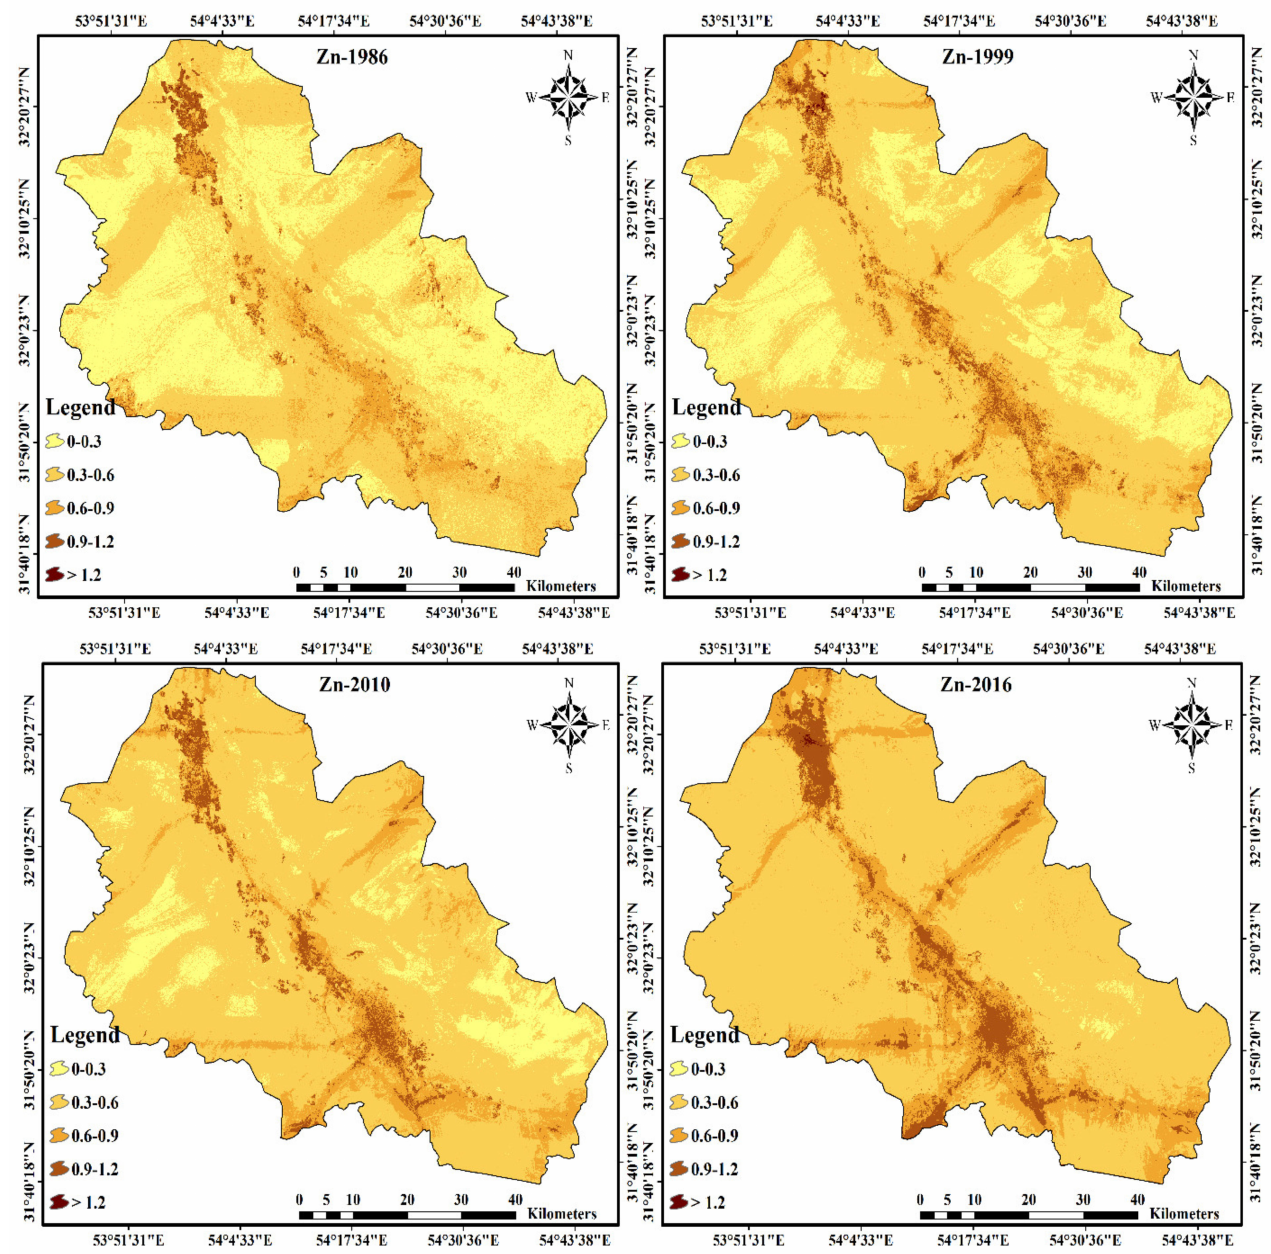
Figure 10. The spatial prediction of Zn (mg/kg − 1 ) for 1986, 1999, 2010, and 2016. With respect to Pb concentrations, the areal extent of the 1–1.5, 1.5–2, and >2.5 mg/kg − 1 classes increased by 8.75% (42,258 ha), 25.18% (121,633 ha), and 2.18% (10,562 ha), respec- tively, while the areal extent of the 0–1 mg/kg − 1 class decreased by 36.56% (176,565 ha) (Figure 11). Furthermore, the Pb concentration maps indicated that the distribution of Pb was focused at the center to the southern and western regions of the study area (shown in dark brown—Figures 9 and 11). In these areas, high concentrations of Pb were due to its accumulation from mines, factories, agricultural lands, gardens, and residential lands. The reason for this may be the tendency of this element to accumulate in smaller soil particles (clay and silt) [65]. Our results were in accordance with the findings of Facchinelli et al. [66], who identified that the sources of Pb in the soil were controlled by human